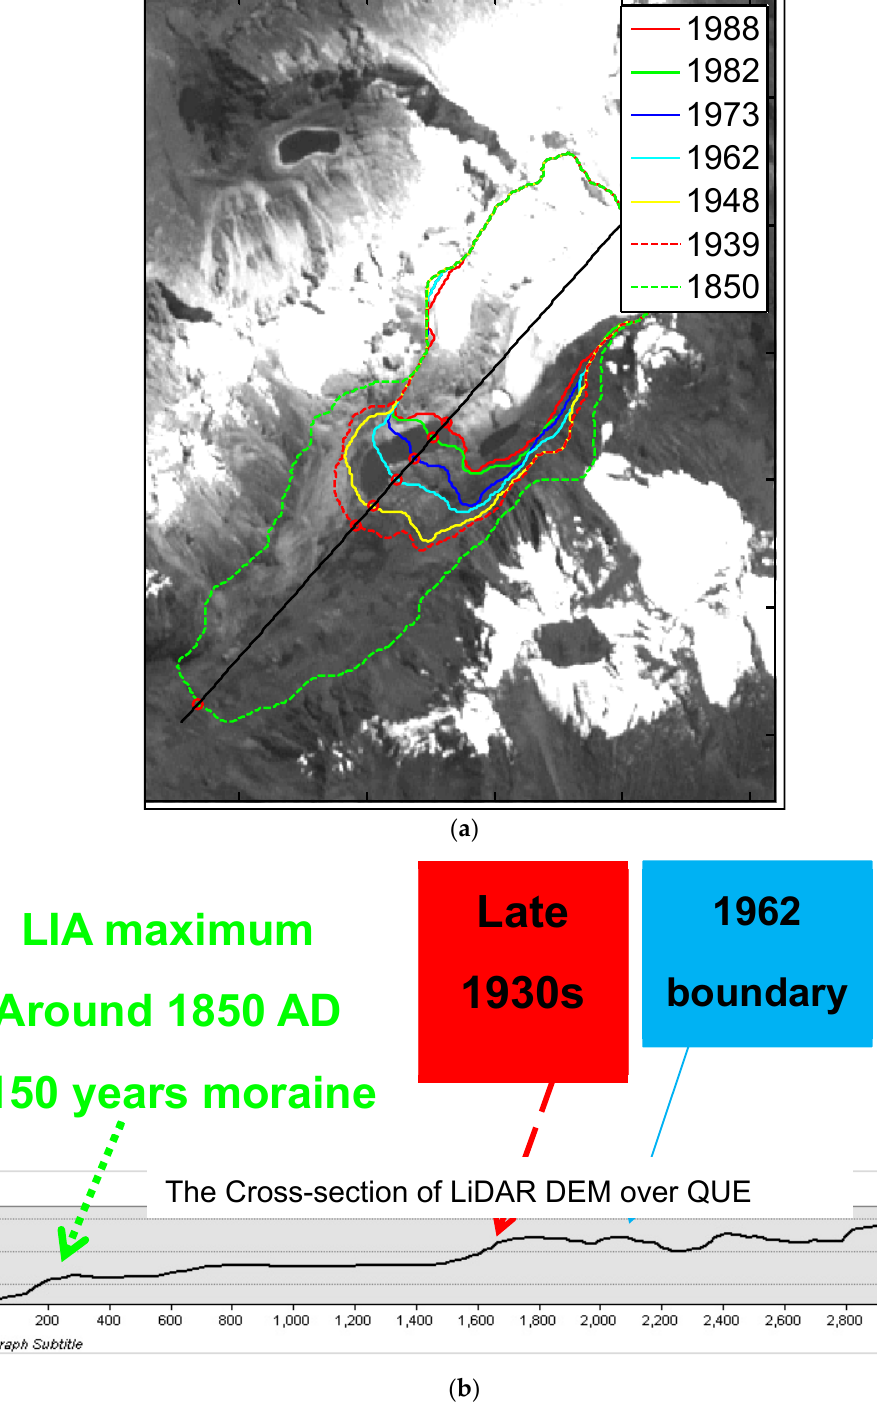
Figure 7. ( a ) The simulation result of the time series of modeled glacier terminus positions from the LIA maximum (1850 AD) to 1988 AD for QUE. ( b ) The cross-section of the LiDAR DEM was employed to verify the LIA moraine positions over QUE.